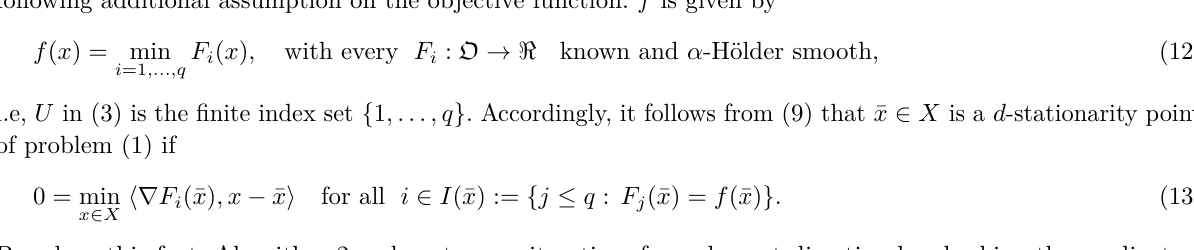
FW algorithm for minimizing upper C 1 ,α functions